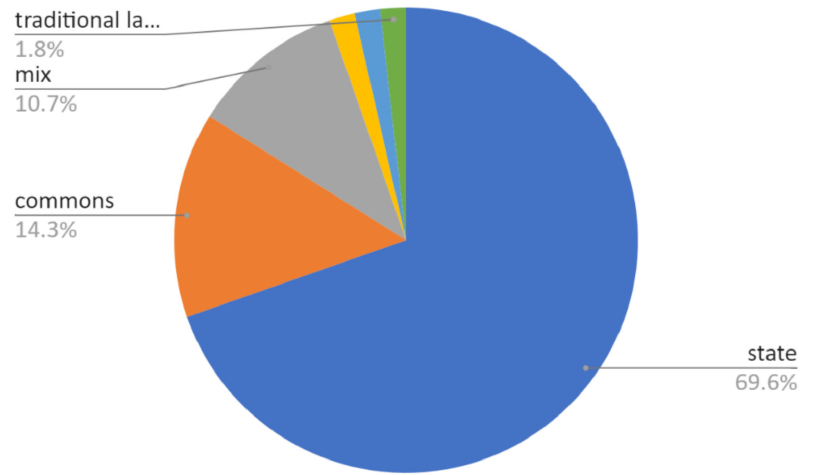
Figure 6. Forest